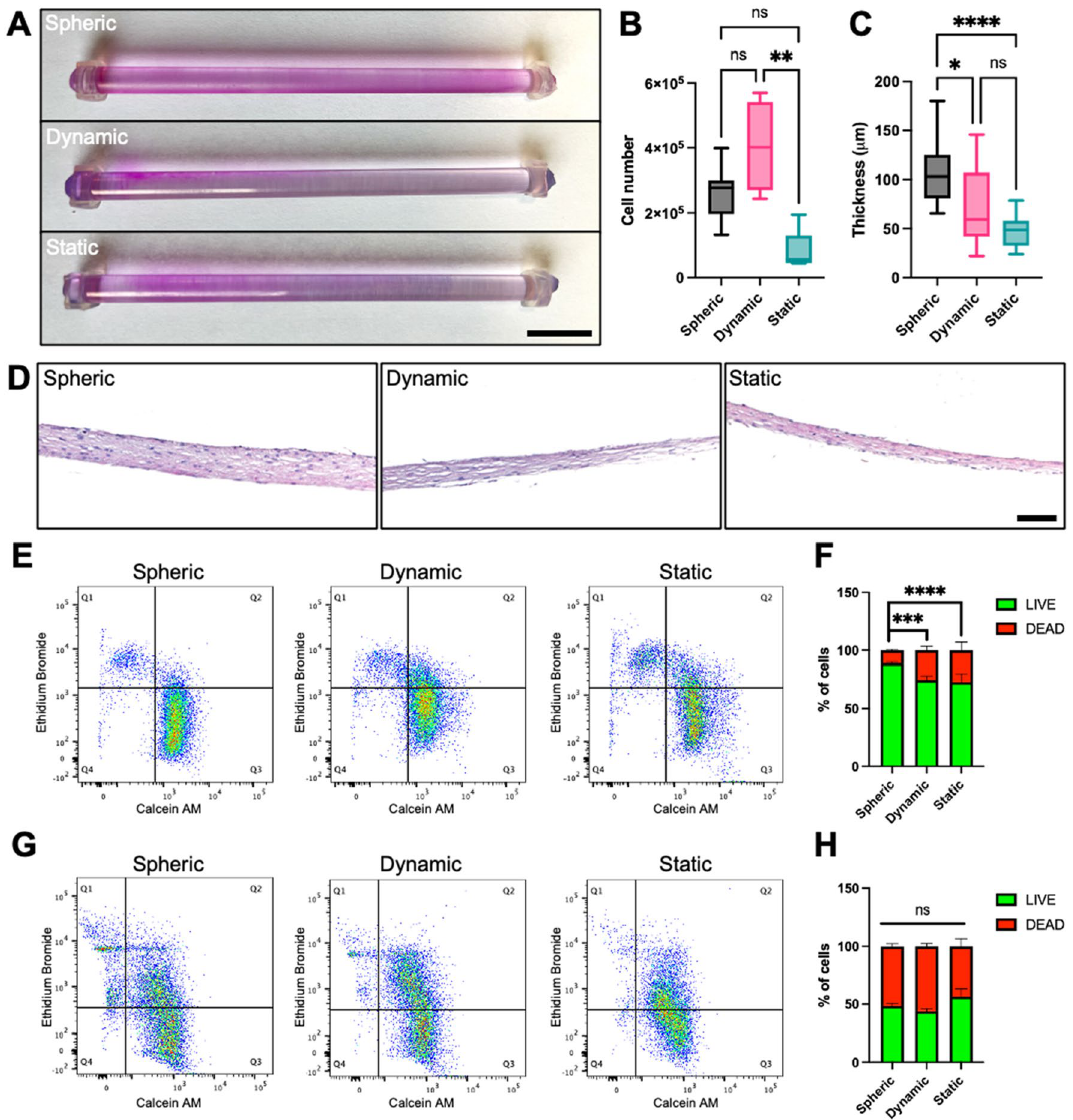
Figure 4. Cellular distribution and viability in post-seeded and matured TEBV-A produced by different seeding techniques. ( A ) Photograph of Rhodanile Blue stained cells on PETG scaffold post-seeding. Scale bar = 1 cm; ( B ) number of cells adhered to the scaffold following a 22-h seeding period; ( C ) TEBV-A tissue thicknesses (µm) measured after a 42 day maturation period; ( D ) Hematoxylin and eosin (H&E) staining of histological sections collected from matured TEBV-A produced using different seeding techniques (spheric, dynamic and static). Scale bar = 100 µm; ( E,F ) Live/dead assay on post-seeded TEBV-A harvested cells analyzed by flow cytometry; ( G,H ) Live/dead assay on matured TEBV-A harvested cells. ( B , C) Box and whiskers with max and min. For statistical analyses, a Kruskal–Wallis test with Dunn’s multiple comparison test was performed. n = 4–24. ( F,H) Stacked bars with standard deviation. For statistical analyses, a two-way ANOVA with Tukey’s multiple comparison test was performed. n = 5. * P < 0.05, ** P < 0.01, *** P < 0.001 and **** P < 0.0001. ns